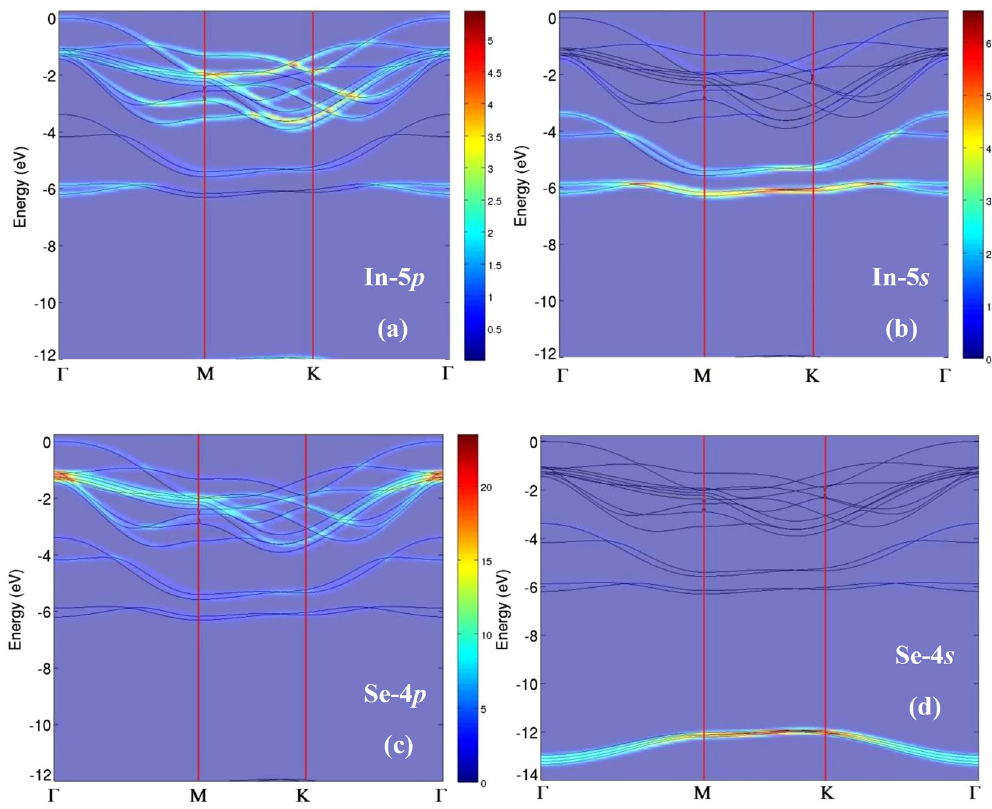
Figure 3. Theoretical band structure projected to ( a ) In-5p; ( b ) In-5s; ( c ) Se-4p; and ( d ) Se-4s atomic orbitals. The intensity of the various bands is plotted in a colour scale, whose legend is reported in the right part of panels ( a ) and ( b ) and between panels ( c ) and ( d